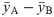
Nonoverlap proportion and point-biserial correlation.Theoretical curves and estimated values for point-biserial correlation, rpb, nonoverlap proportion, ρpb, and sample size adjusted correlation, rpbd, for simulated data with unequal sample sizes (NA : NB = 15000 : 500) and the difference between mean values, y¯A−y¯B. Compared to rpbd, rpb is attenuated due to the confounding effect of the binomial sampling factor. A: Uniform unit width (σ=1/12) distributions. B: Standard normal (σ = 1) distributions.